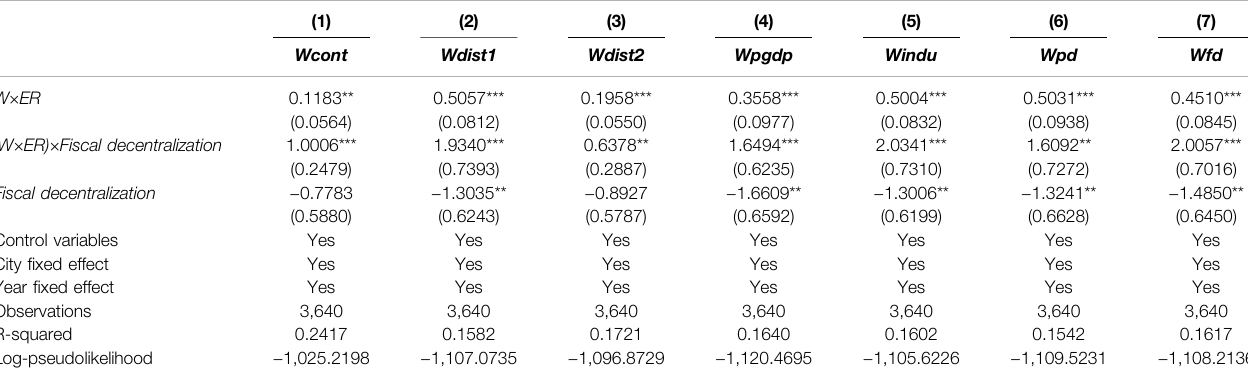
TABLE 10 | Estimates for fi scal decentralization and strategic interactions in environmental